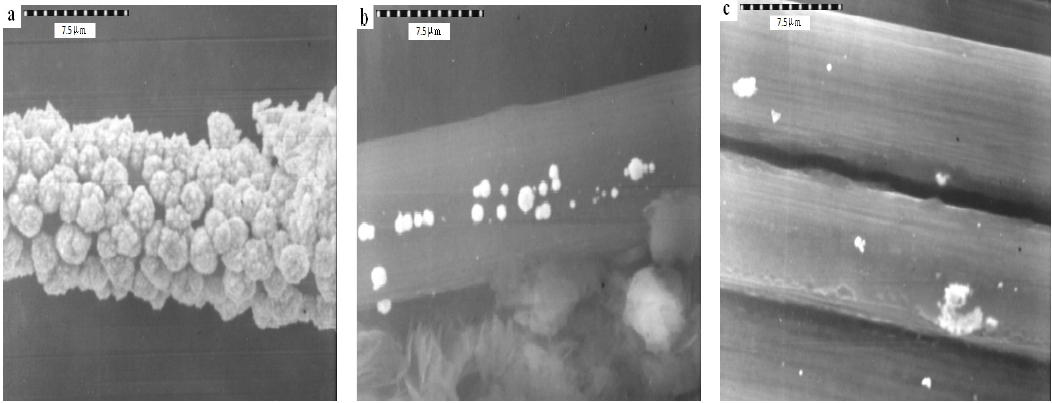
Figure 10. Gold particles distribution in the carbon fiber: ( a ) a bundle of carbon fiber is composed of 8 single fiber; ( b ) a bundle of carbon fiber is composed of 16 single fiber; ( c ) a bundle of carbon fiber is composed of 32 single